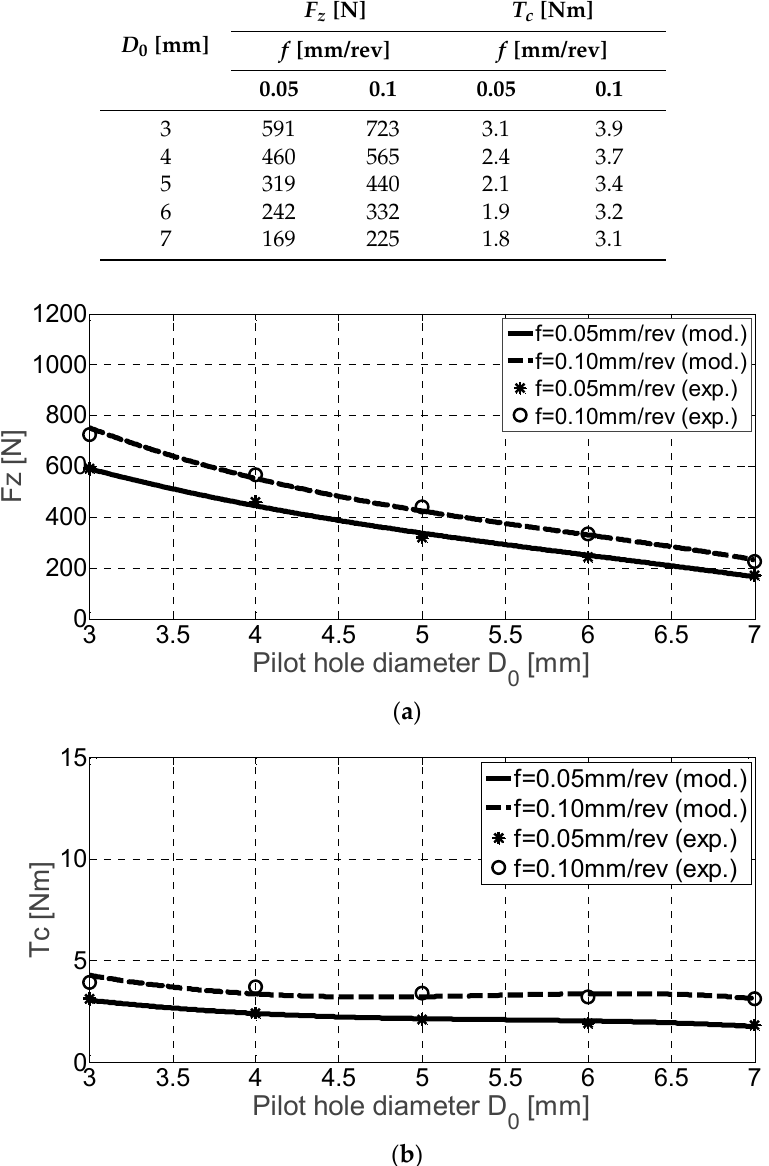
Figure 5. F z [N] ( a ) and T c [Nm] ( b ) for Ti-6Al-4V alloy drilling experimental and mechanistic model values.